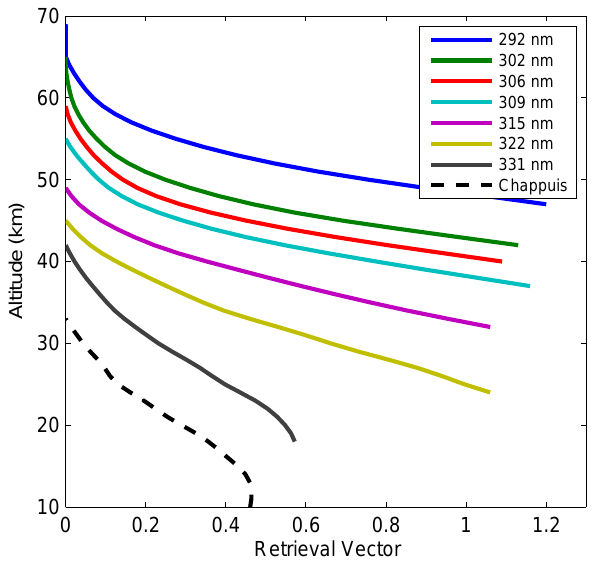
Fig. 2. A sample set of the 9 OSIRIS pair/triplet measurement vec- tor elements used in the ozone retrieval. See Table 1 for complete definitions. Values of the two Chappuis triplets are indistinguish- able in this